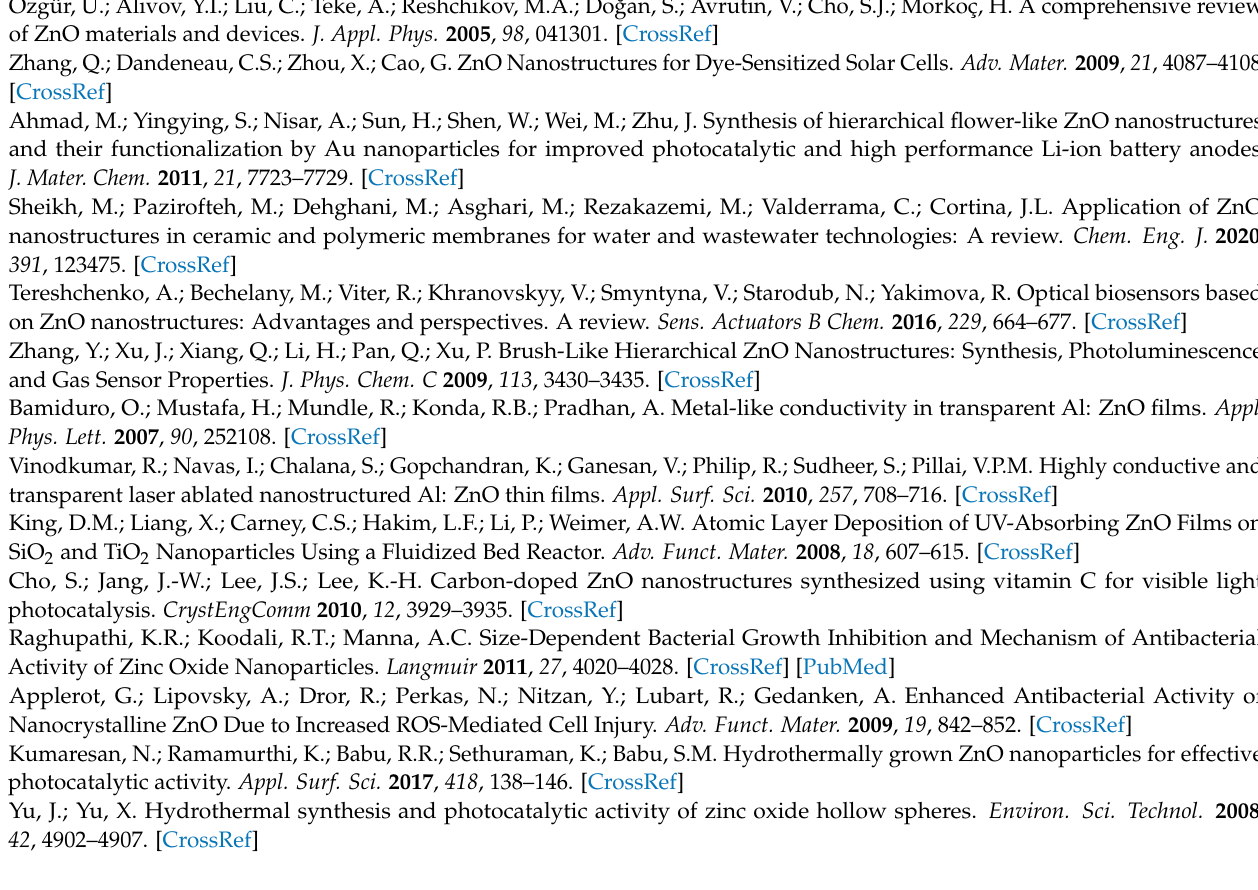
XRD instrument peak width calibration, Figure S3: WH plots of milled powders, Figure S4: ZnO polycrystalline aggregate size calculated using DLS, Figure S5: Tauc plots for direct band gap calculation of milled NPs, Figure S6: TEM images of 2 Cycles, Figure S7: TEM images of 5 cycles, Figure S8: TEM images of 8 cycles, Figure S9: FTIR spectra of milled powders, Figure S10: Beer– Lambert calculations for methyl orange